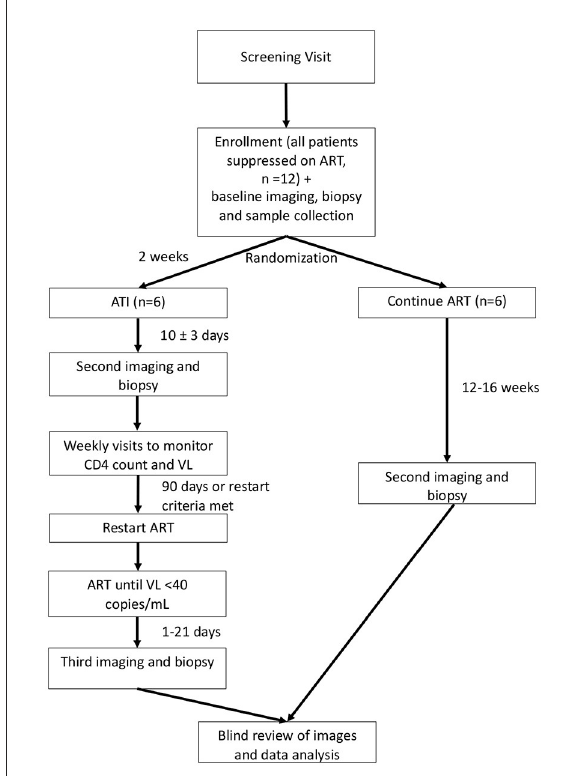
FIGURE1 Study schema. ART, antiretroviral therapy; ATI, analytic treatment interruption; VL, viral load. Depicts the overall schema for participant randomization and study procedures. Participants will be randomized 1:1 to continue ART or undergo ATI. ATI participants will undergo a total of three PET/CTs with biopsy, while those who continue ART will receive two PET/CTs with